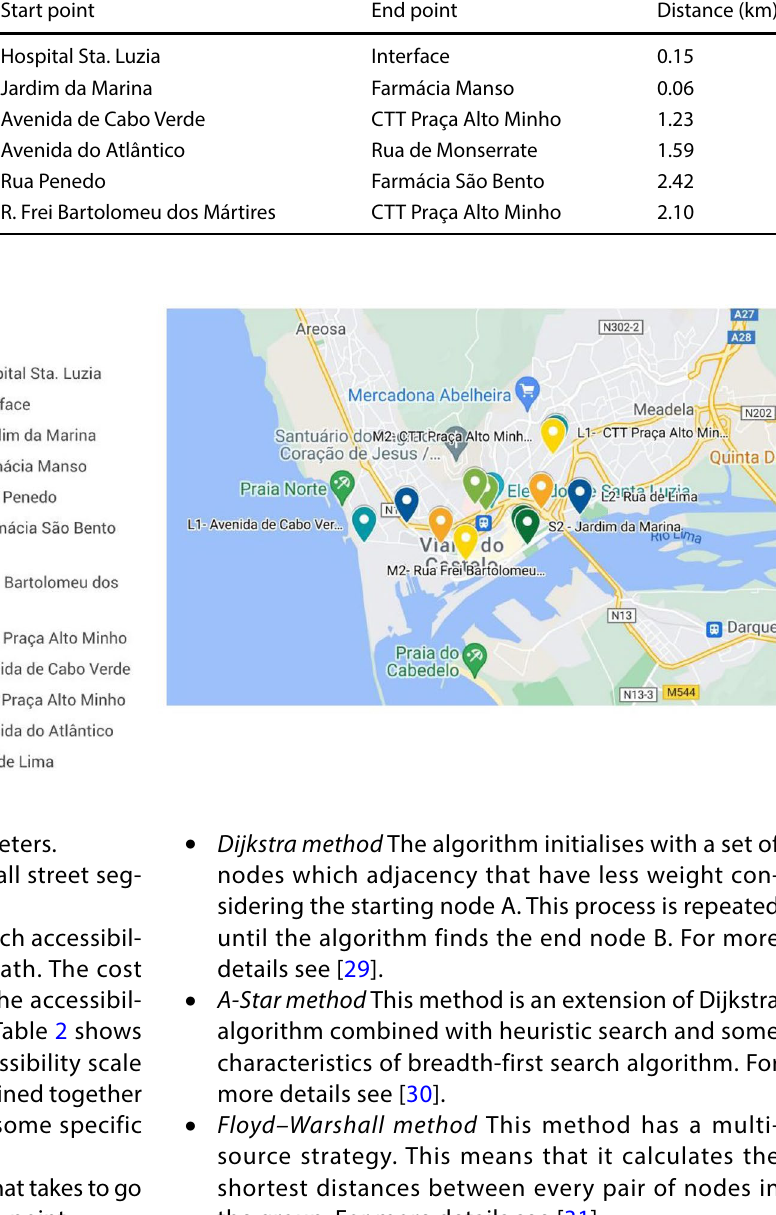
Table 3 Paths identification